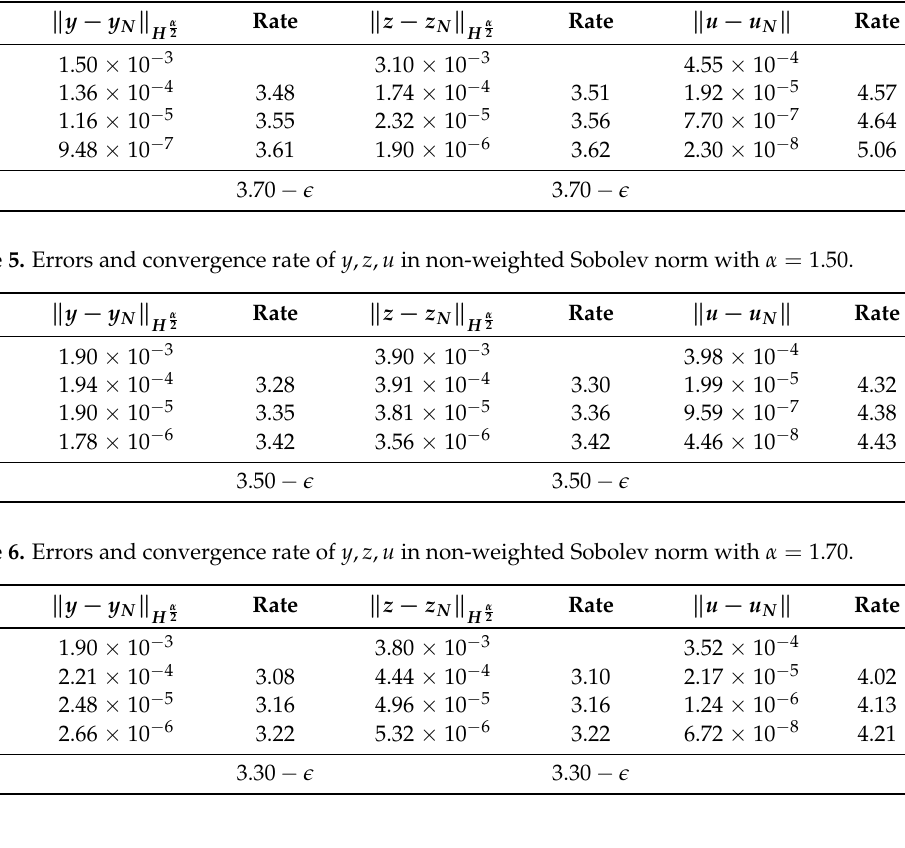
Table 4. Errors and convergence rate of y , z , u in non-weighted Sobolev norm with α = 1.30. N